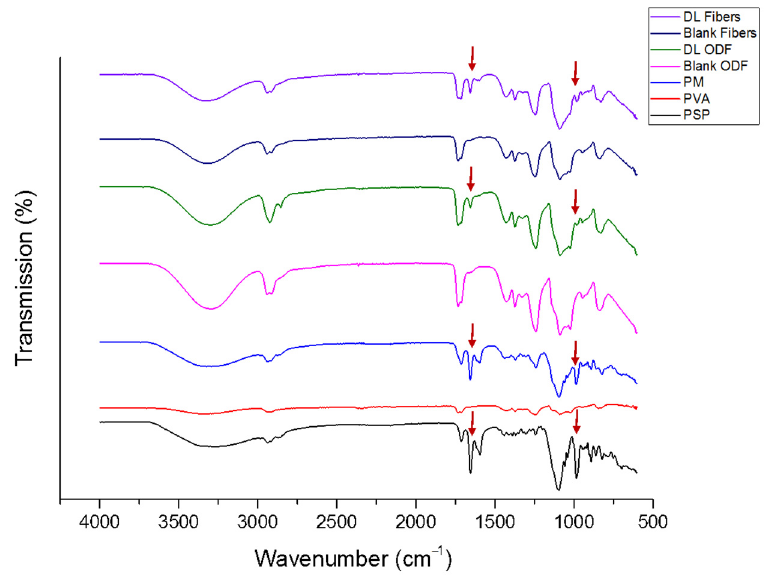
Figure 5. Fourier Transform Infrared (FTIR) transmissions of PSP, PVA, PM, blank and drug-loaded nanofibers, and ODFs showing the distinctive drug peaks at 1686 cm − 1 and 1014 cm − 1 that appear in the PM and the DL fibers and ODFs compared to the blank formulations. PM: physical mixture; DL: drug-loaded.